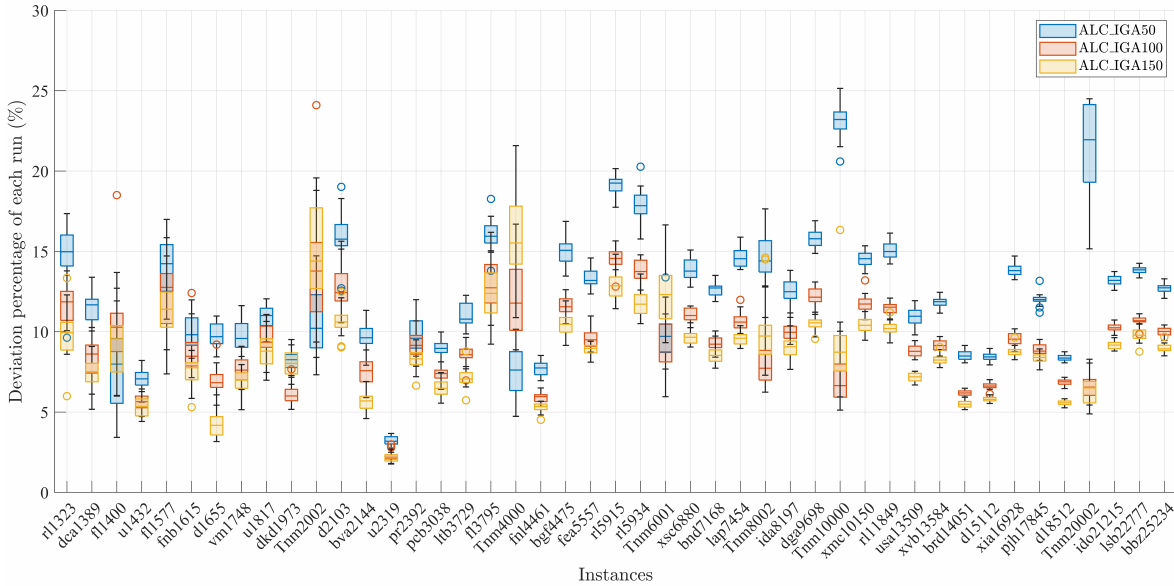
Figure 6. The deviation percentage of each run on 45 medium-scale instances with M set to 50, 100, and 150.